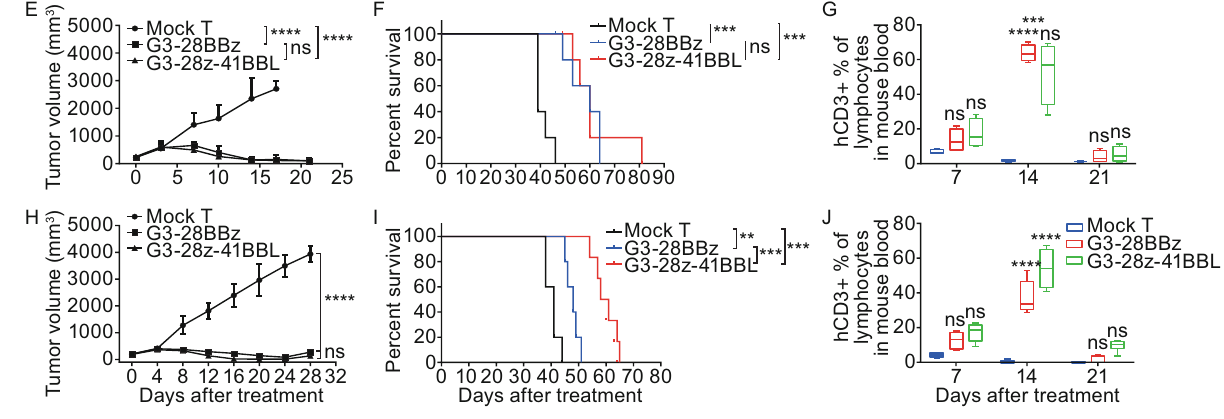
B-cell leukemia and lymphomas have generated impressive results. More promisingly, Zhao et al. recently have com- pared a series of CD19-CARs with various 4-1BB and CD28